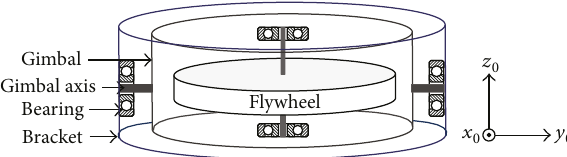
Figure 4: Schematic diagram of the CMG